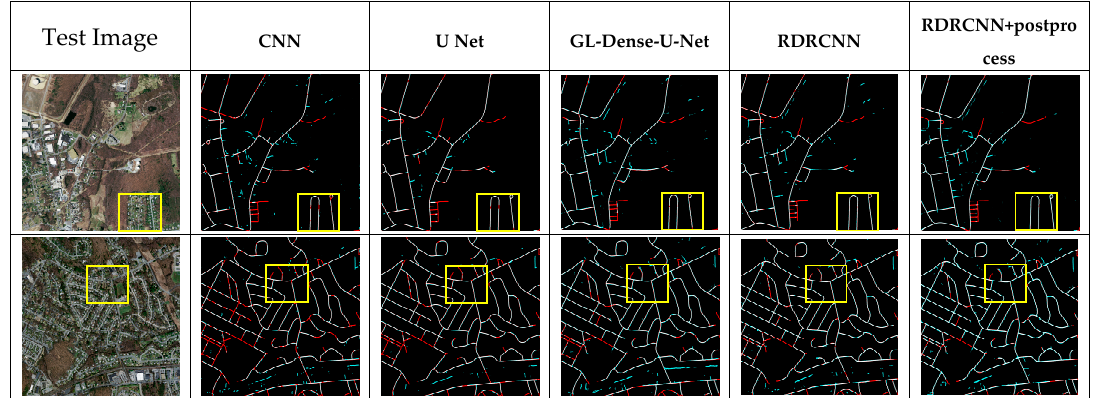
Figure 7. The legends for Figures 8–11.